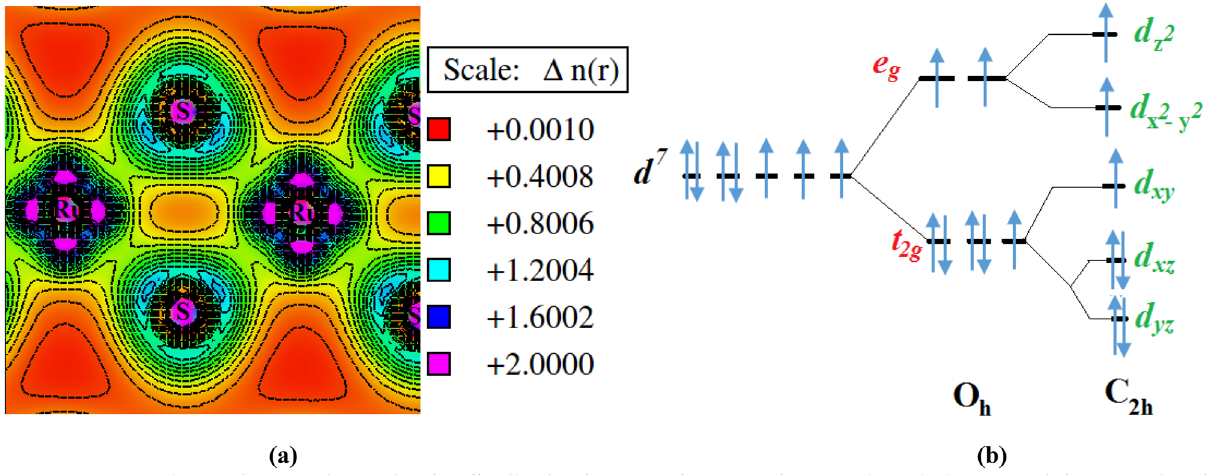
Figure 5. (a) Valence electron charge density distribution in marcasite RuS 2 along a selected plane containing Ru–S bonds ,illustrating high covalent and low ionic bonding. (b) Crystal field splitting of Ru- 4d levels in marcasite RuS 2 under C 2h